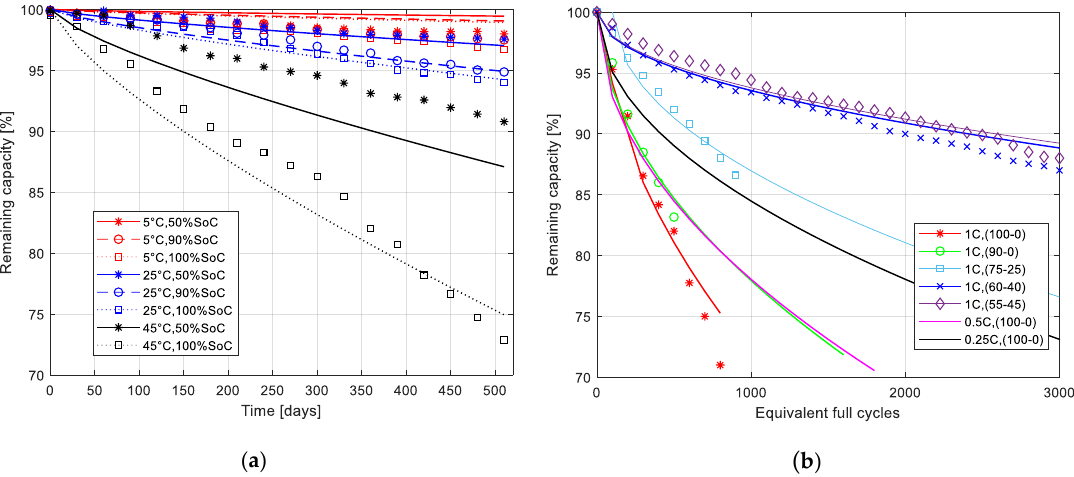
Figure 6. Simulated (line) and measured (marker) remaining capacity for empirical model ( a ) calendar aging at various SoC values and temperatures with the experimental data from [68]; ( b ) cycling aging at various DoD windows (in brackets) and currents at T = 35°C with experimental data from [61].